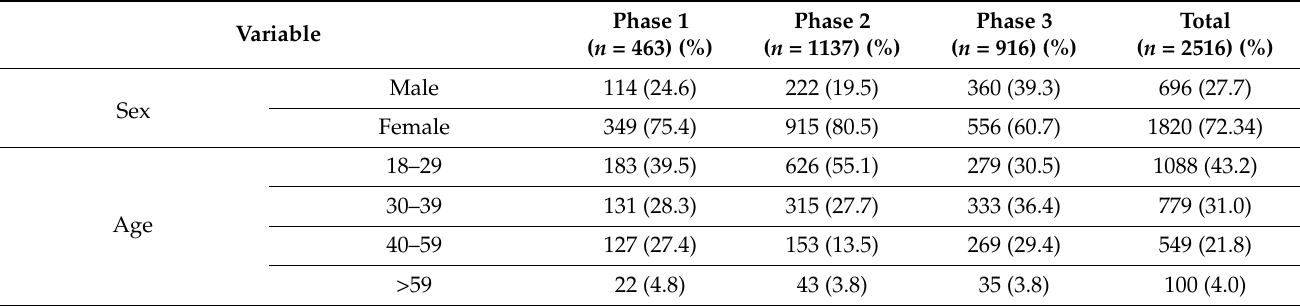
Table 1. Characteristics of the study